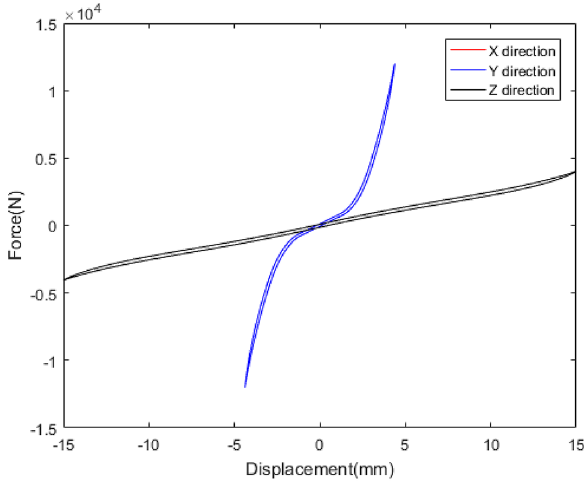
Figure 2. Translational stiffness in x/y/z direction.